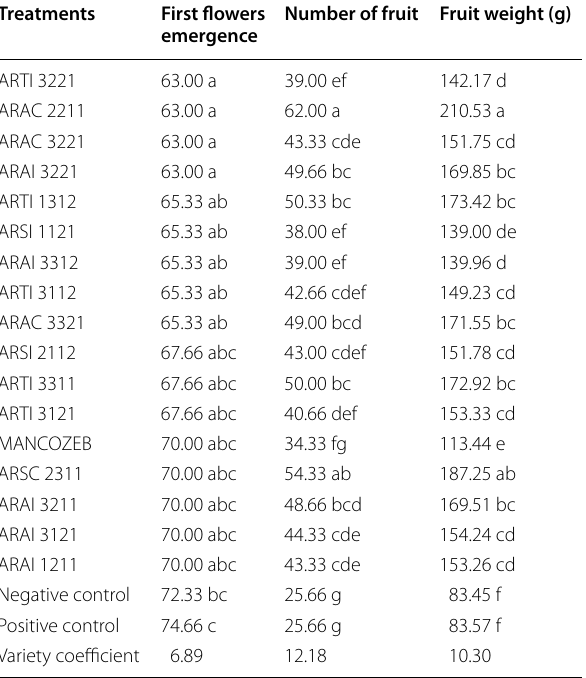
Table 3 Appearance of the first flower, number of fruits, and fruit weight of chili introduced by actinobacteria isolates Treatments